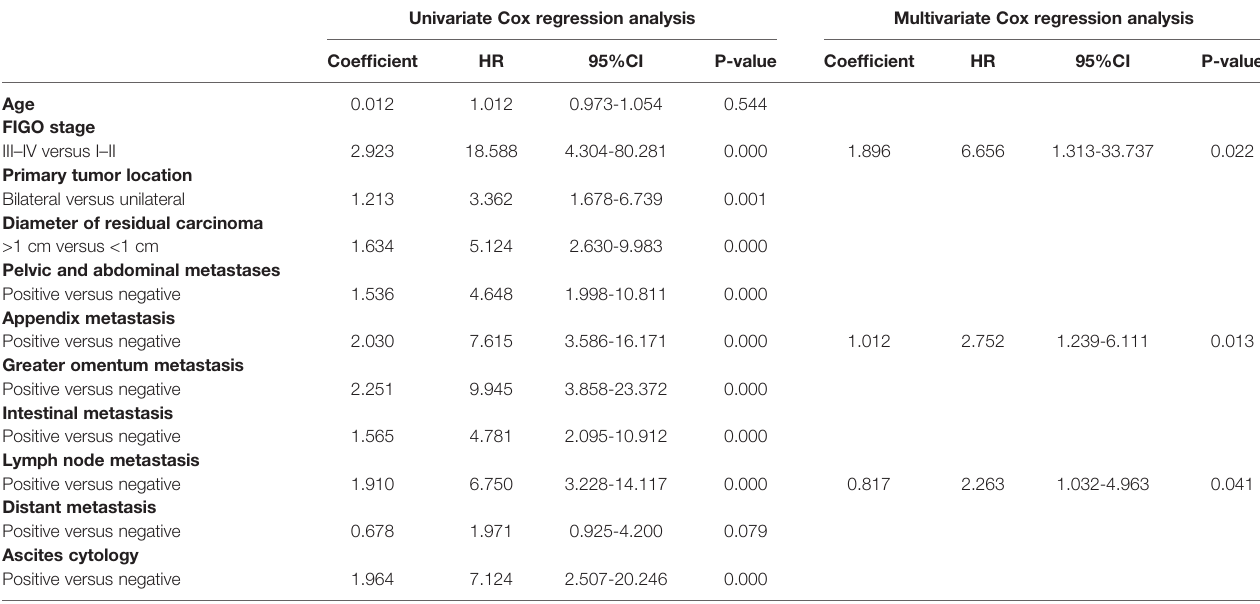
TABLE 2 | Univariate and multivariate Cox proportional hazards regression analysis of risk factors associating with PFS in 121